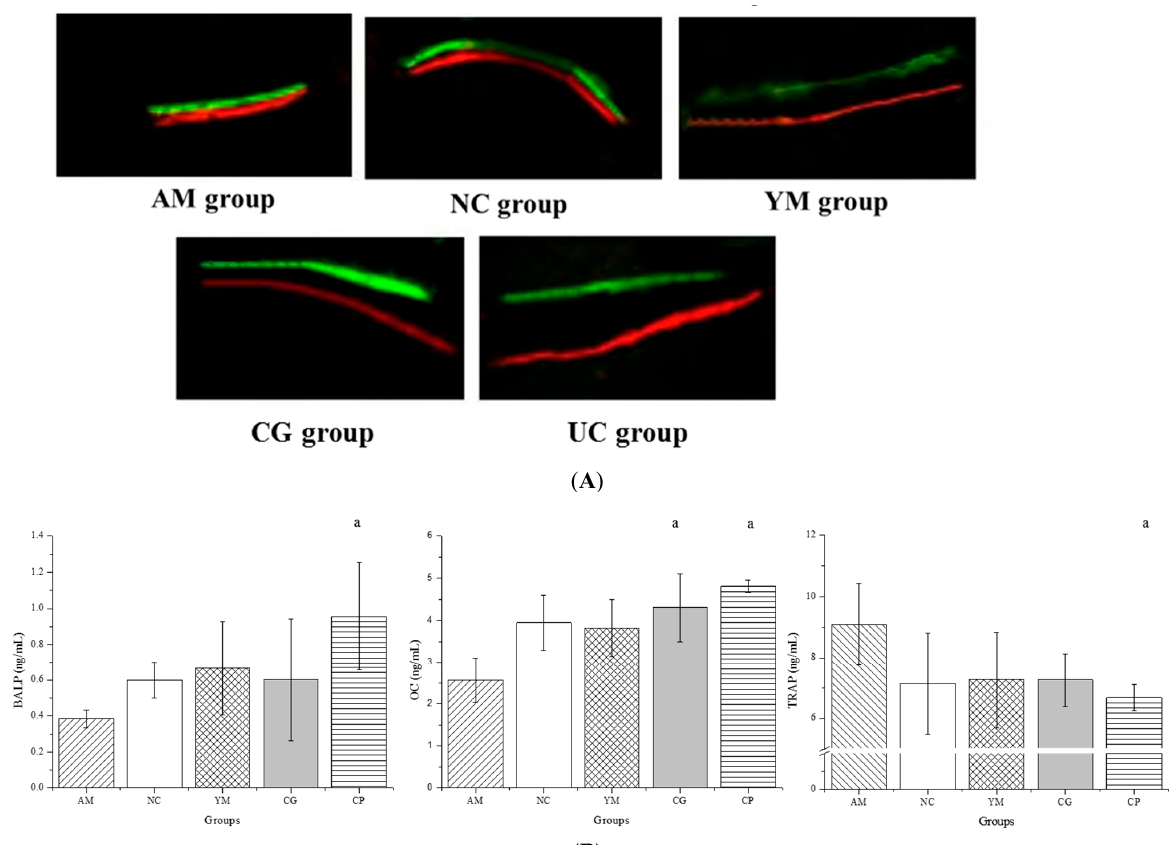
Figure 3. Dynamic histomorphometric and biochemical markers of bone turnover analyses. ( A ) Dynamic histomorphometric analyses of representative fluorescence images ( n = 5); ( B ) serum levels of biochemical markers of bone turnover ( n = 5, 7, 9, 9, and 10 in the AM, CG, UC, NC, and YM groups); a p < 0.05 versus the AM group.